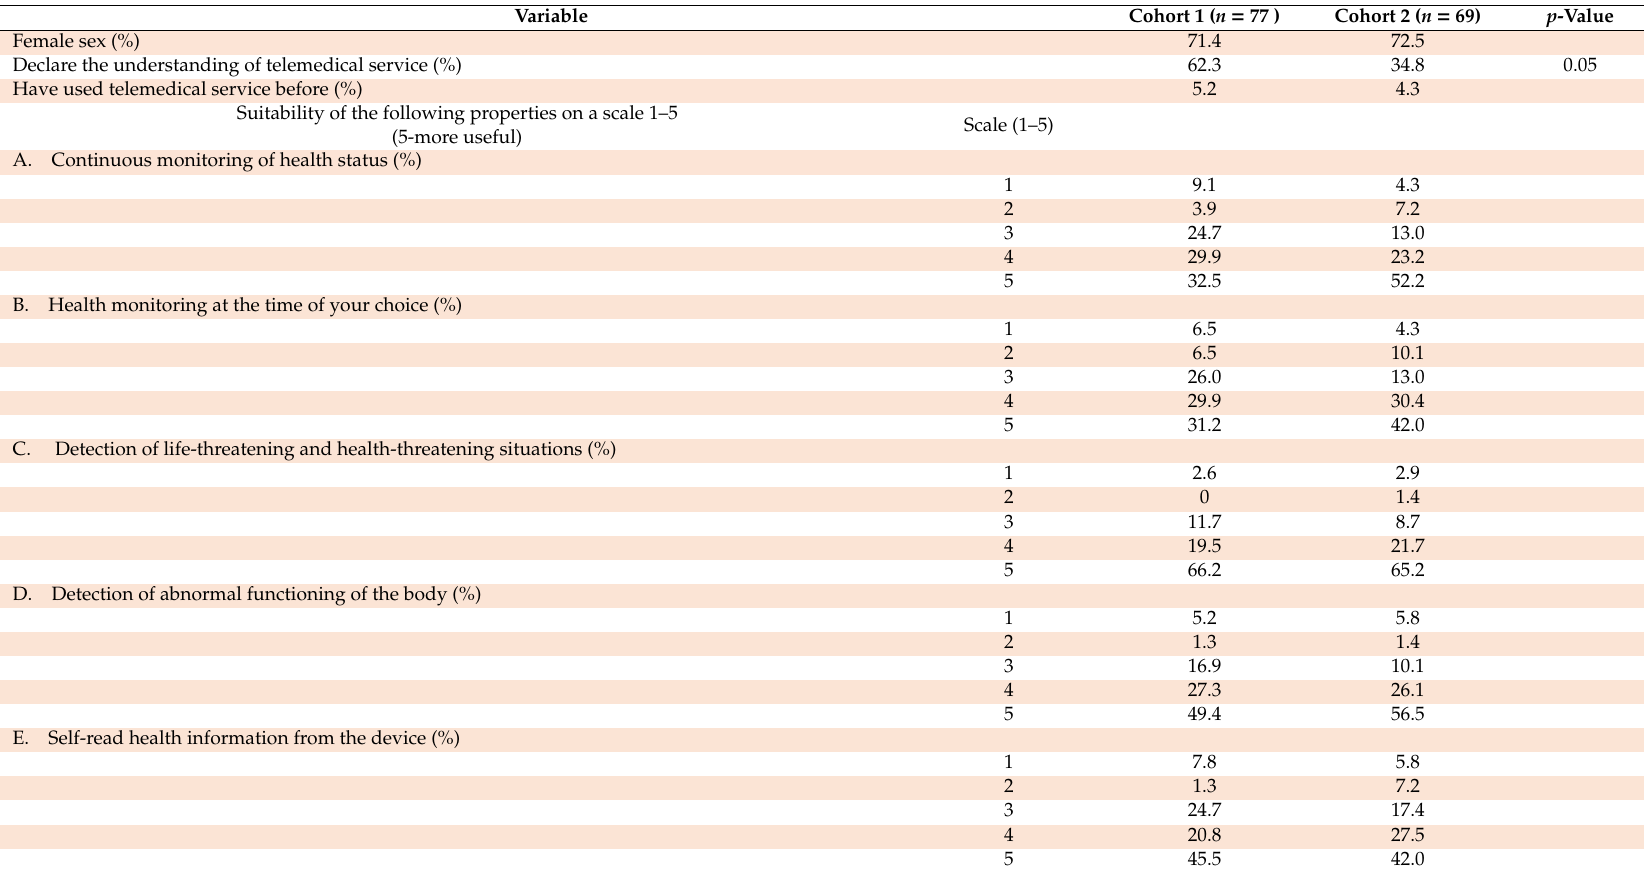
Table 1. A comparison of results between the two cohorts (cohort 1 vs. cohort